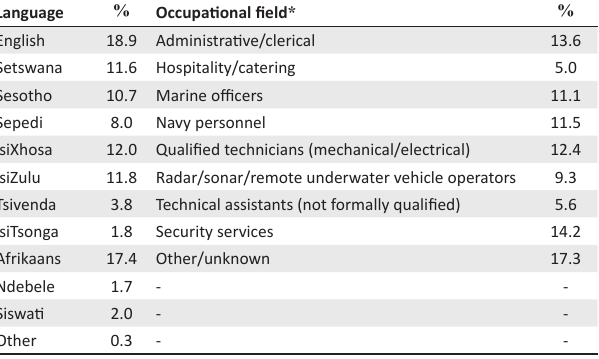
TABLE 1: Sample composition in terms of home language and occupational field.